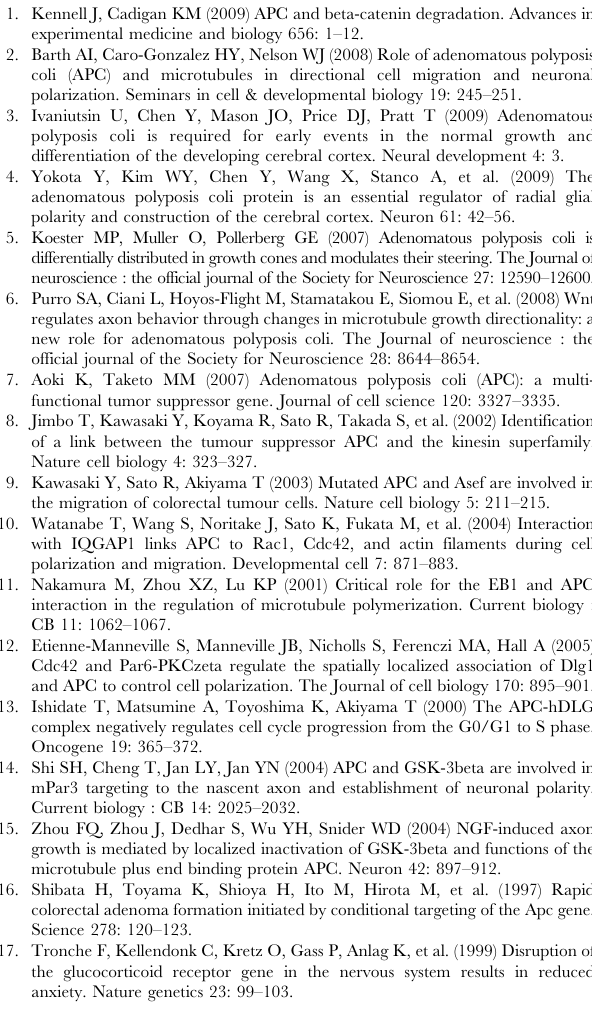
growth cones from APC lox/lox Nestin-Cre + mice were assessed. ***: P , 0.001 by student t test. (TIF) Figure S2 Fluorescent intensity of APC-N, APC-C, APC- C1 and APC-C2 expression in APC deficient neurons. Data are shown from a representative experiment. Histograms represent integrative GFP fluorescent intensity of neurons expressing each fragment measure by Metamorph software. Note that no significant differences were observed among these deletion mutants.